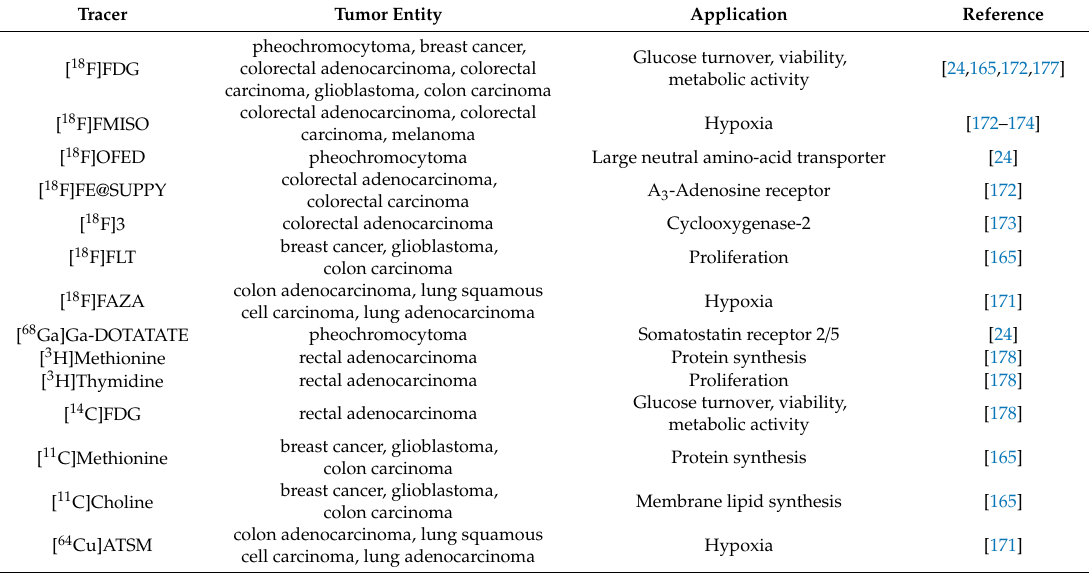
Table 4. Selected examples for established radiotracers and radiotracers still in experimental research that have been used on 3D models of various tumor